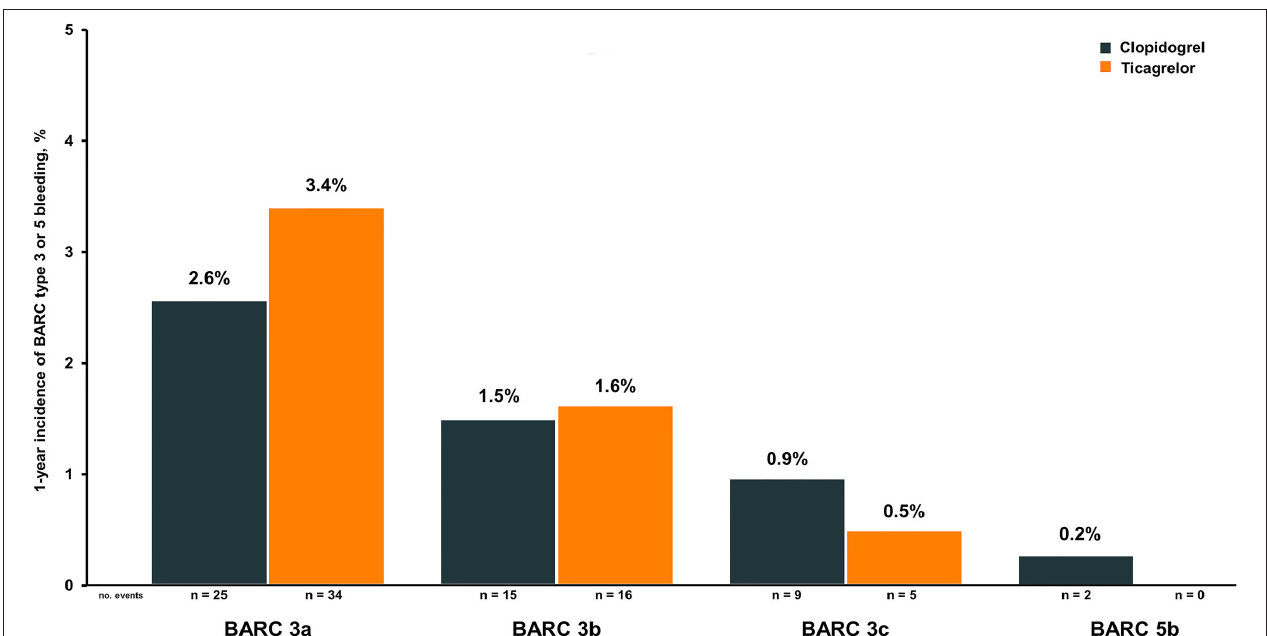
FIGURE 2 | Cumulative incidence of BARC Type 3 and Type 5 bleeding events in patients treated with ticagrelor and clopidogrel. BARC, Bleeding Academic Research Consortium.